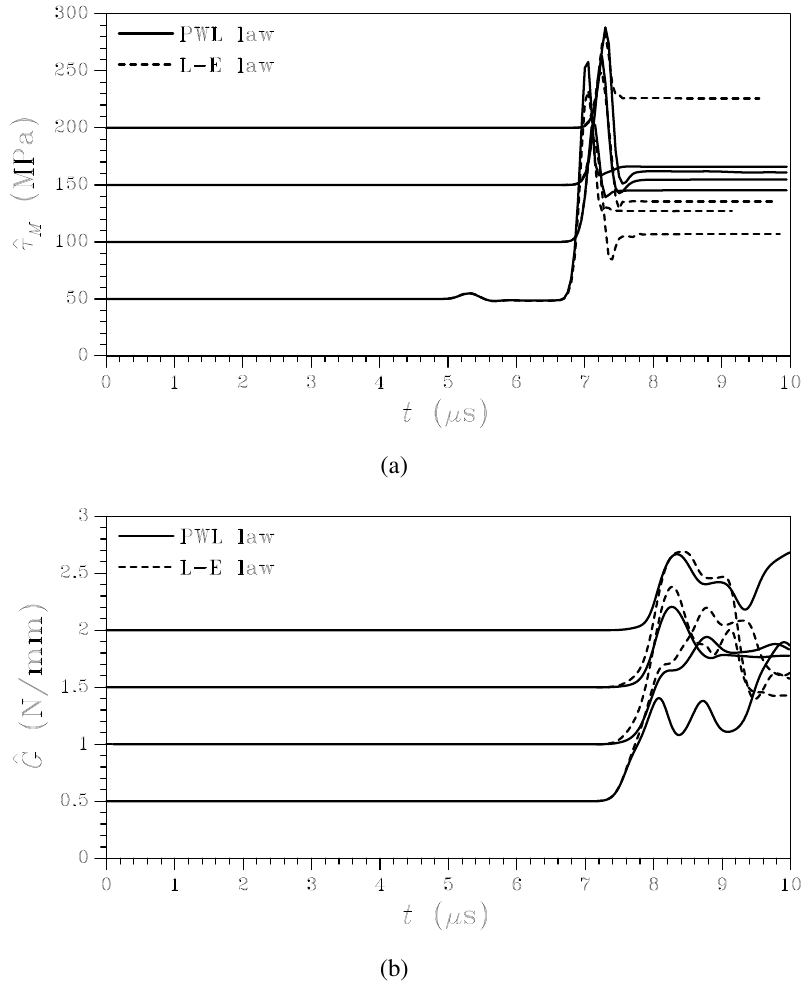
Figure 5. Impact on a 7-layer composite [13]: evolution in time of estimated